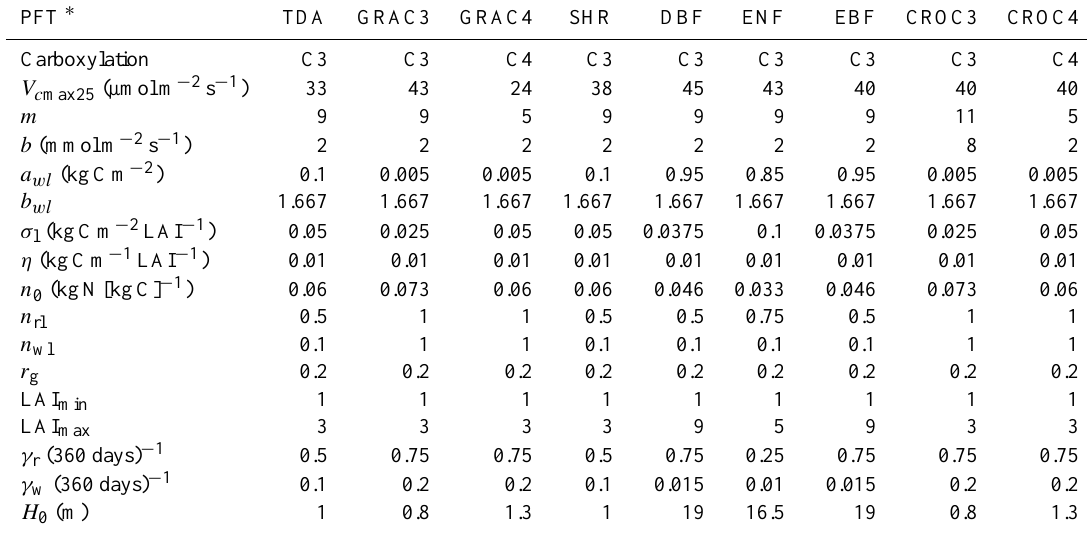
Table 1. Photosynthetic and allometric parameters for the vegetation